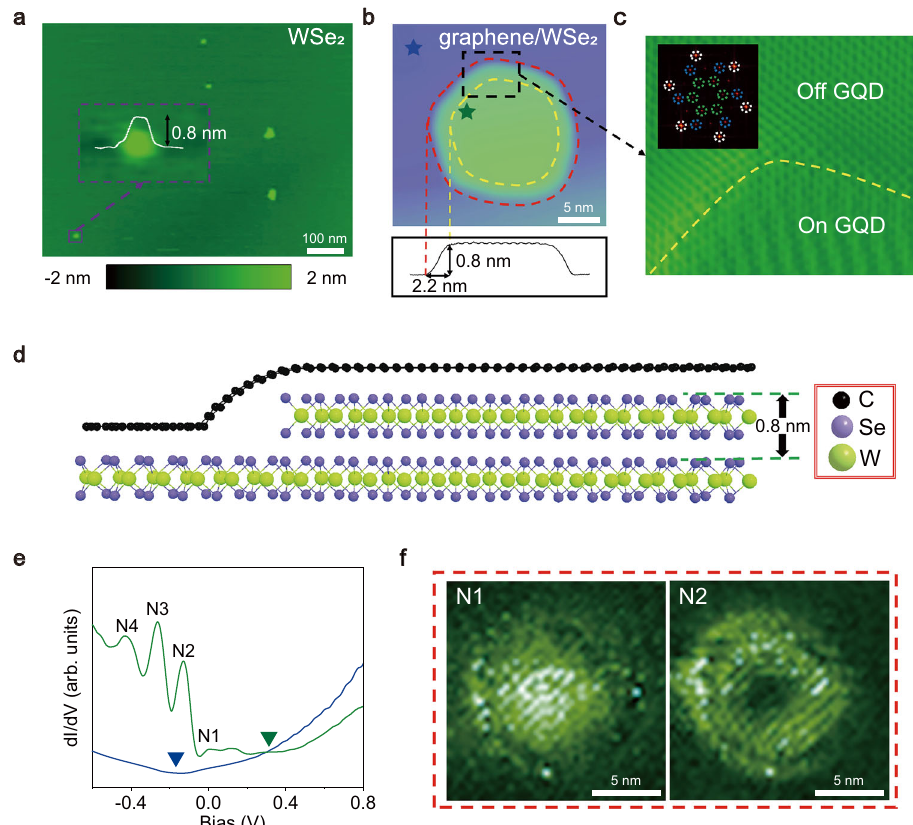
Fig. 1 The structures and general d I /d V features of Graphene/WSe 2 heterostructure. a A representative AFM image of the freshly mechanical exfoliated WSe 2 sheet. Inset: the AFM image of a typical monolayer WSe 2 island. b A STM image of a typical graphene/WSe 2 heterostructure quantum dot (QD). The height of the graphene quantum dot (GQD) is ~0.8 nm and the width of edge area of the GQD is ~2.2 nm. c The zoom-in image of the area in black dashed squares from panel b . Inset: the FFT of graphene/WSe 2 heterostructure. The bright spots in the white dotted circles represent the reciprocal lattice of graphene, the bright spots in the blue dotted circles represent the reciprocal lattice of WSe 2 , and the bright spots in the green dotted circles represent moiré structure of the graphene/WSe 2 heterostructure. d Schematic structure of the graphene/WSe 2 heterostructure QD. e The d I /d V spectra taken inside [marked by dark green pentagram in b ] and outside [marked by blue pentagram in b ] the GQD. f The d I /d V maps with different energies [N1 and N2 marked in e ] of the q ffiffiffiffiffiffiffiffiffiffiffiffiffiffiffiffiffiffiffiffiffiffiffiffiffiffiffiffiffiffiffiffi β 2 (cid:3) ð m þ 1 = 2 Þ 2 , E is the D